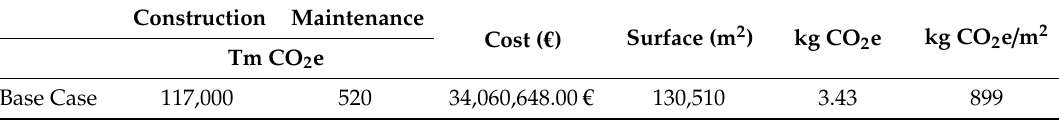
Table 8. Main results of this